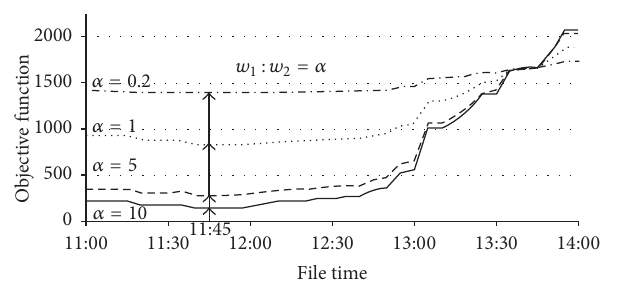
Figure 2: Objective function values corresponding to different file